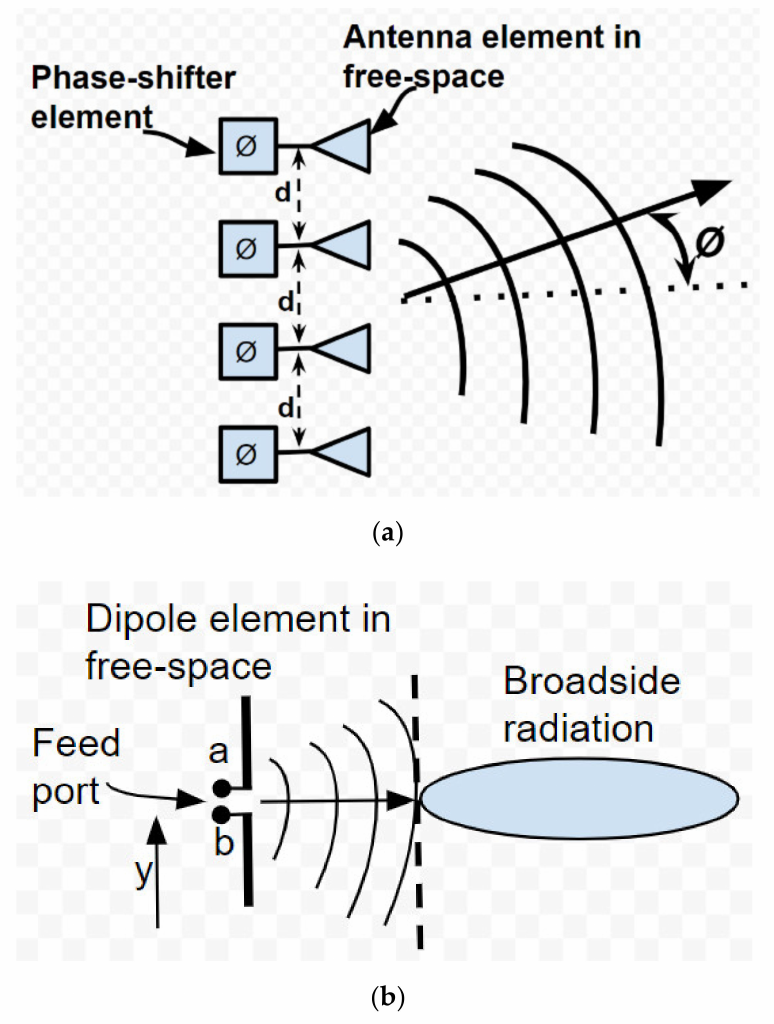
Figure 1. ( a ) A typical phased array antenna for beam-scanning. ( b ) A dipole antenna element along the y-direction in